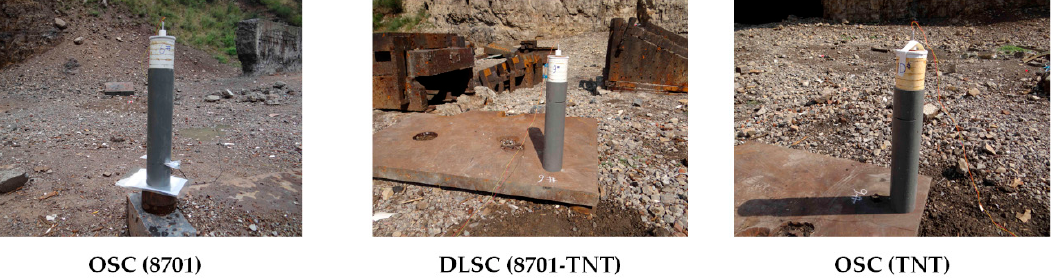
Figure 7. EFP penetration experimental layout of three shaped charges: OSC (TNT), DLSC (8701-TNT) and OSC (8701).